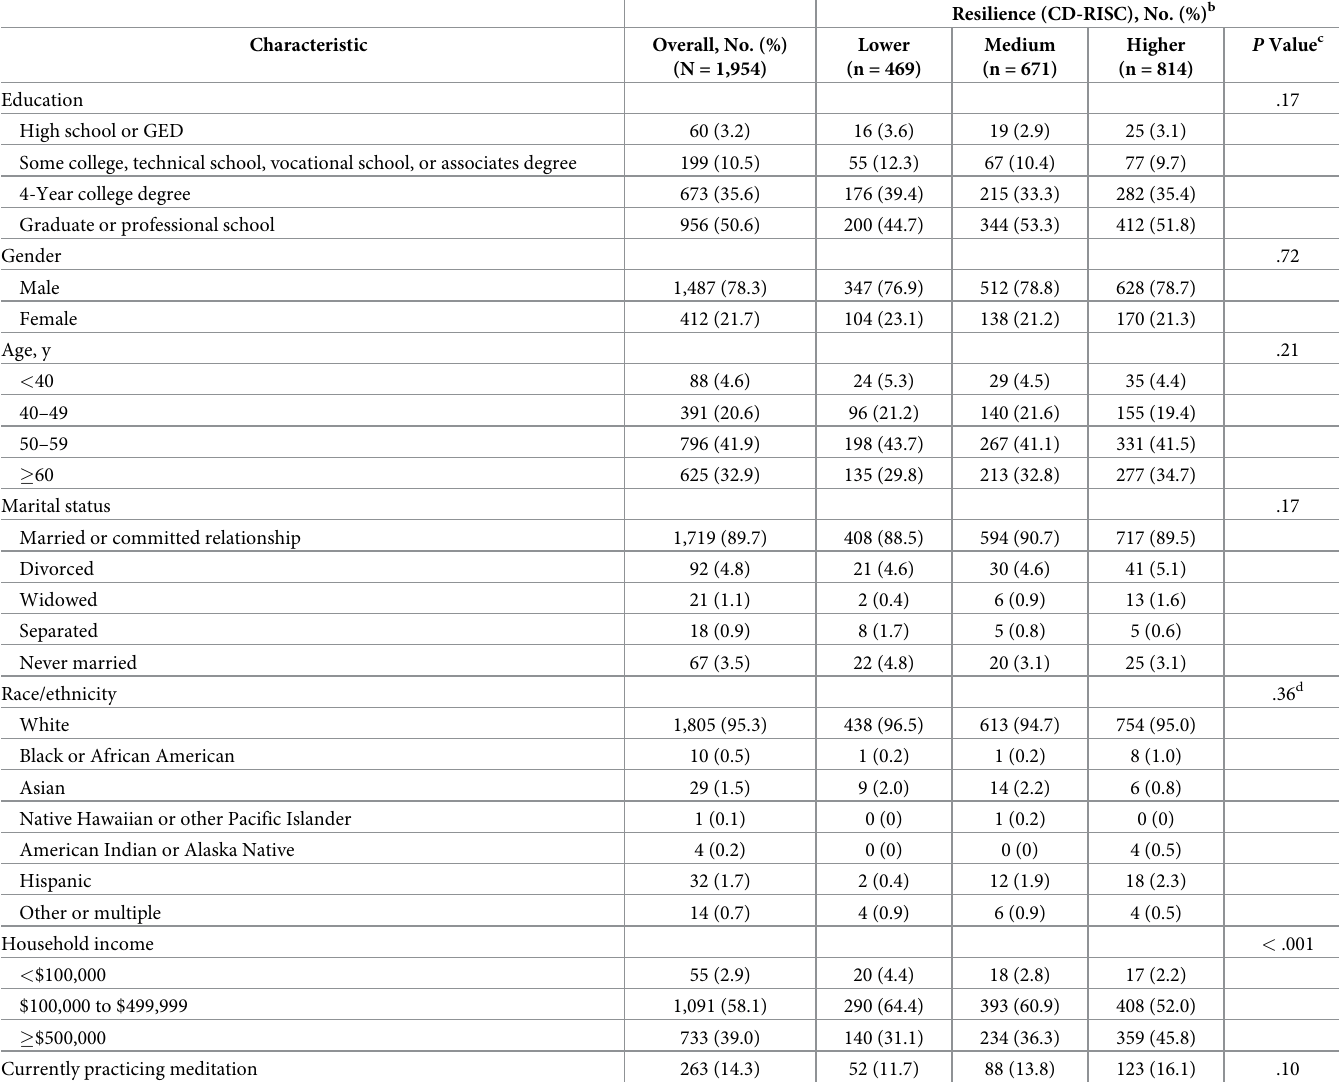
Table 1. Participant characteristics, stratified by resilience level a